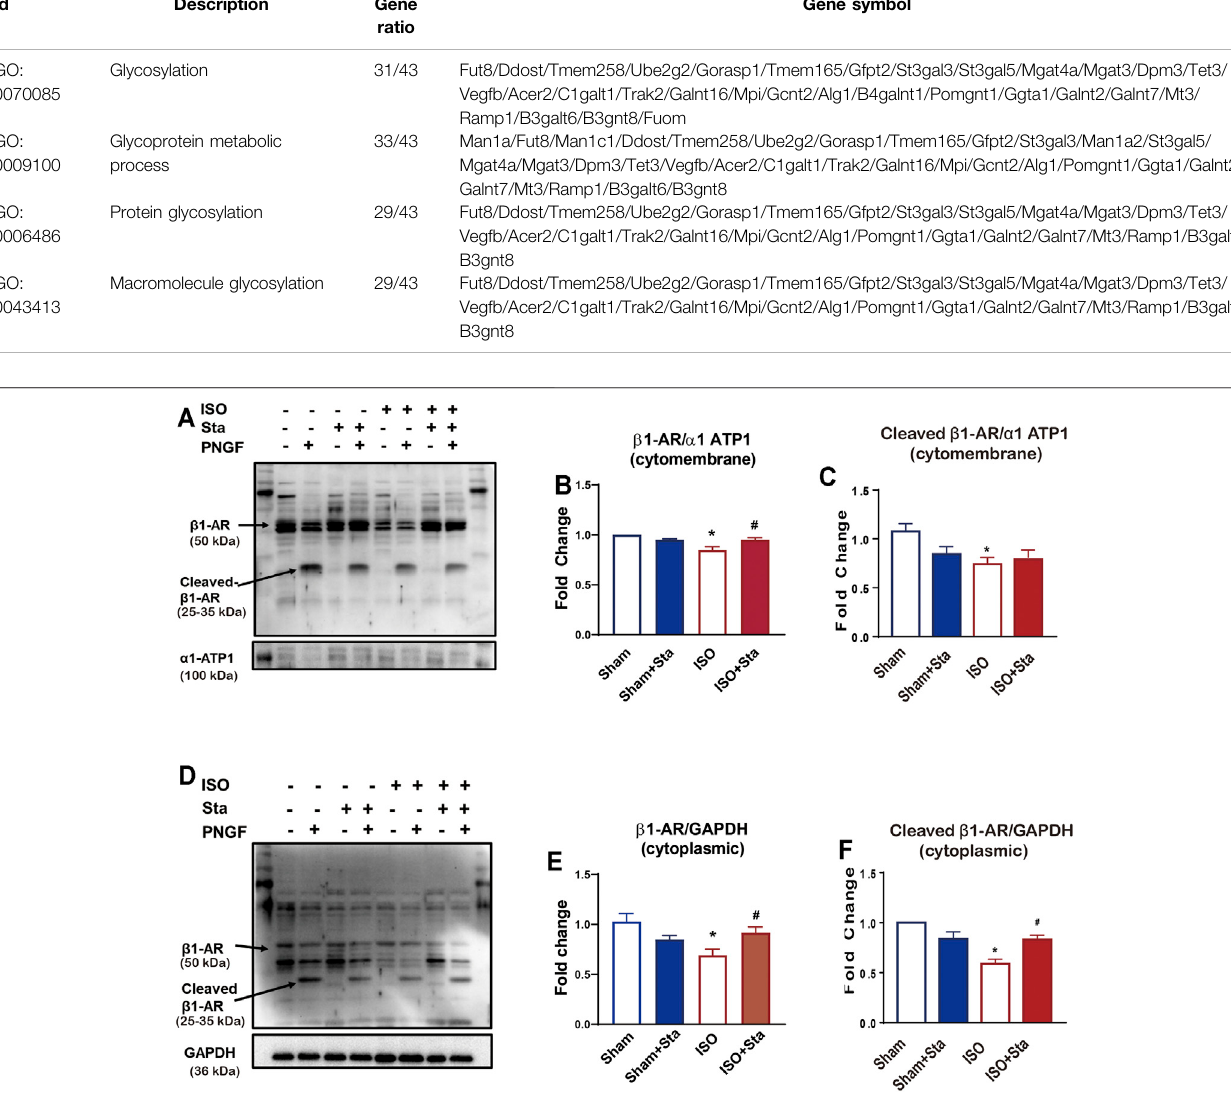
FIGURE 4 | Stachydrine hydrochloride or Sta can increase the N-glycosylation of β 1AR in the heart of mice with ISO-induced heart failure. (A) Representative WesternblotofN-glycosylationof β 1ARonthecellmembrane ofhearttissueafterPNGaseFdigestion. (B,C) Quanti fi cationof β 1ARandN-glycosylationof β 1ARonthe cellmembrane. (D) RepresentativeWesternblotofN-glycosylationof β 1ARinthecytoplasmofhearttissueafterPNGaseFdigestion. (E,F) Quanti fi cationof β 1ARandN- glycosylation of β 1AR in cytoplasmic. n = 3 mice per experimental group. The data are expressed as mean ± standard error of mean, * p < 0.05 versus Sham; # p < 0.05 versus ISO. β 1AR, β 1 adrenergic receptors; ISO, isoproterenol; Sta, stachydrine